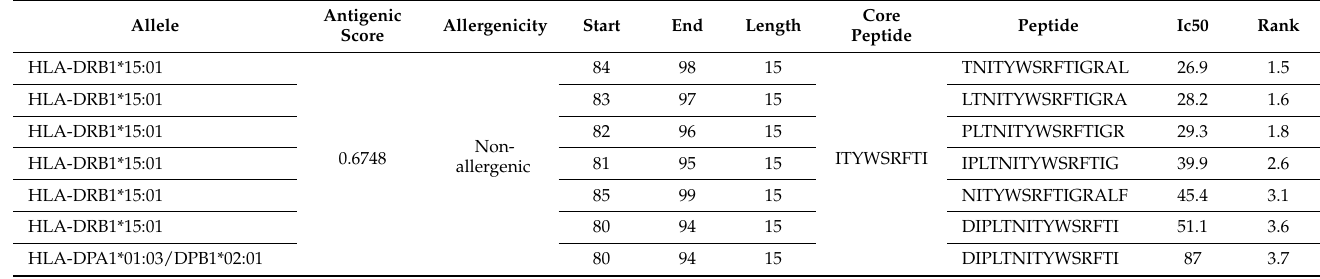
Table 3. MHC class-II